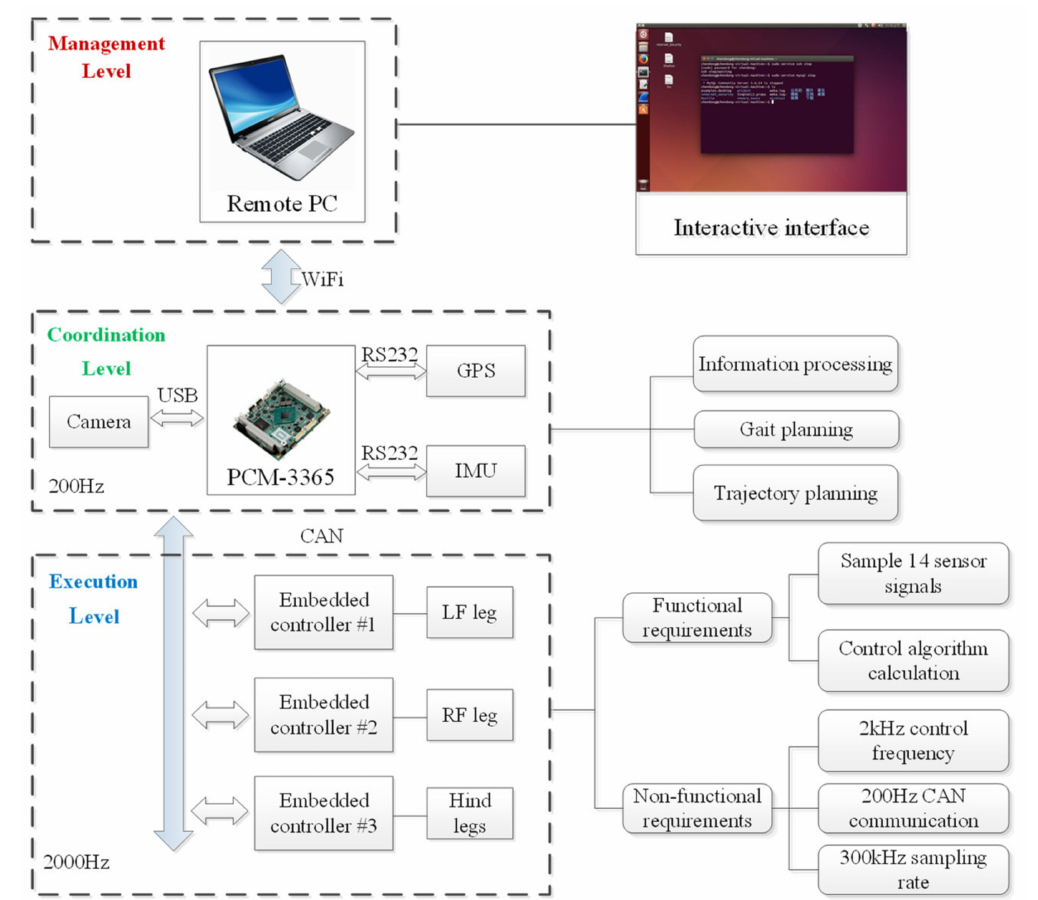
Figure 3. Configuration of the hierarchical control system. (PC: personal computer; GPS: global positioning system; IMU: inertial measurement unit; LF leg: left front leg; RF leg: right front